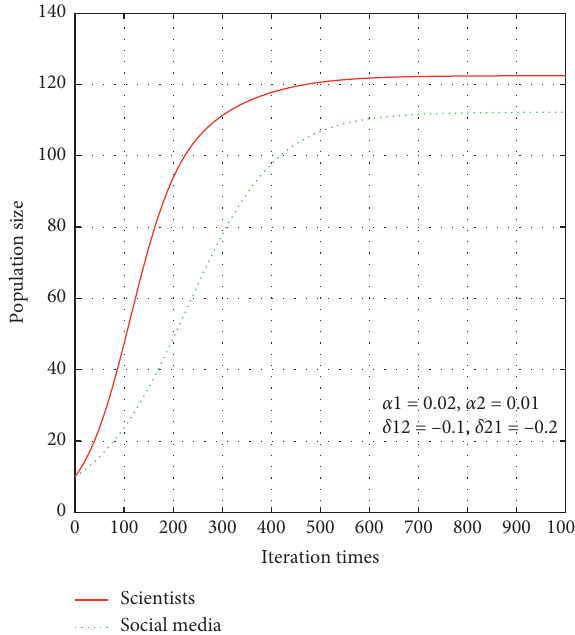
Figure 7: Asymmetric mutualism pattern. Changes in the size of the two populations after 1000 iterations ( α � − 0 . 1, and δ � − 0 . 2). δ 12 21